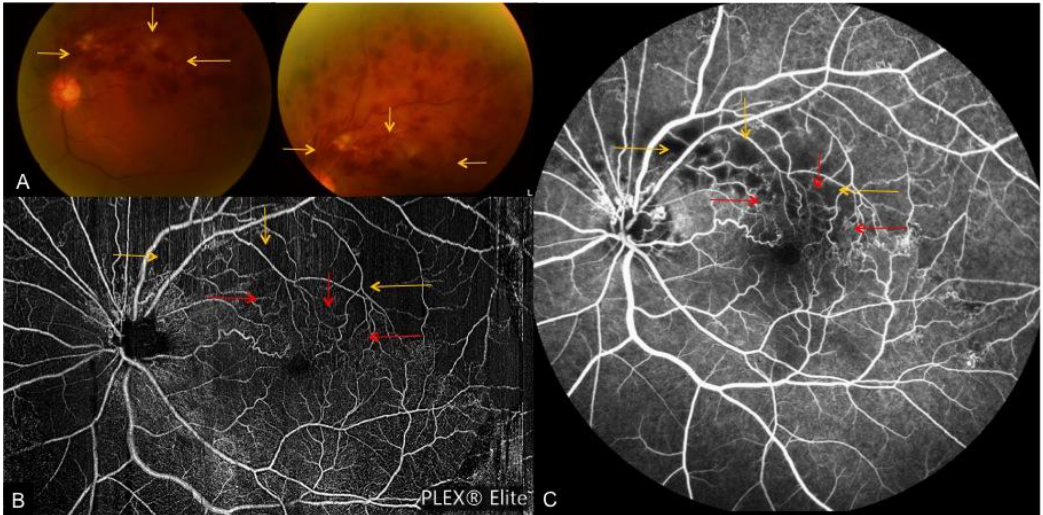
Figure 4. A case of fresh superior-temporal branch retinal vein occlusion. ( A ): Color fundus photos depicting tortuous venous segments with flame-shaped, dot and blot hemorrhages and cotton wool spots. En face OCTA montage ( B ) and FA ( C ) depict associated collateral vessel formation (red arrows), which are blocked by the dense hemorrhage on fundus photos. Yellow arrows indicate areas obscured by the extensive retinal hemorrhage on fundus photo, OCTA and FA.